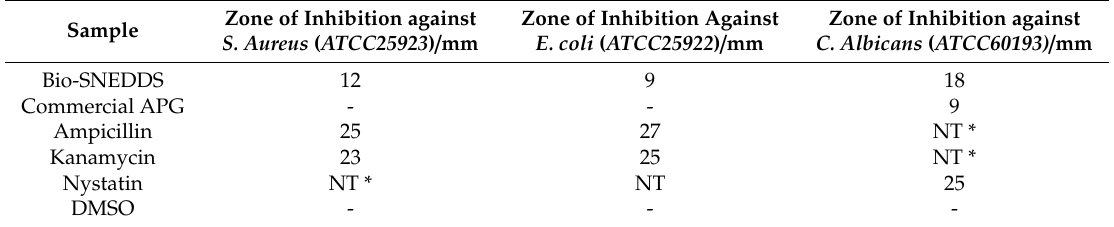
Table 4. Antimicrobial activities of the representative F11-Bio-SNEDDS and the APG commercial capsule against Staphylococcus Aureus , Escherichia coli and Candida albicans .